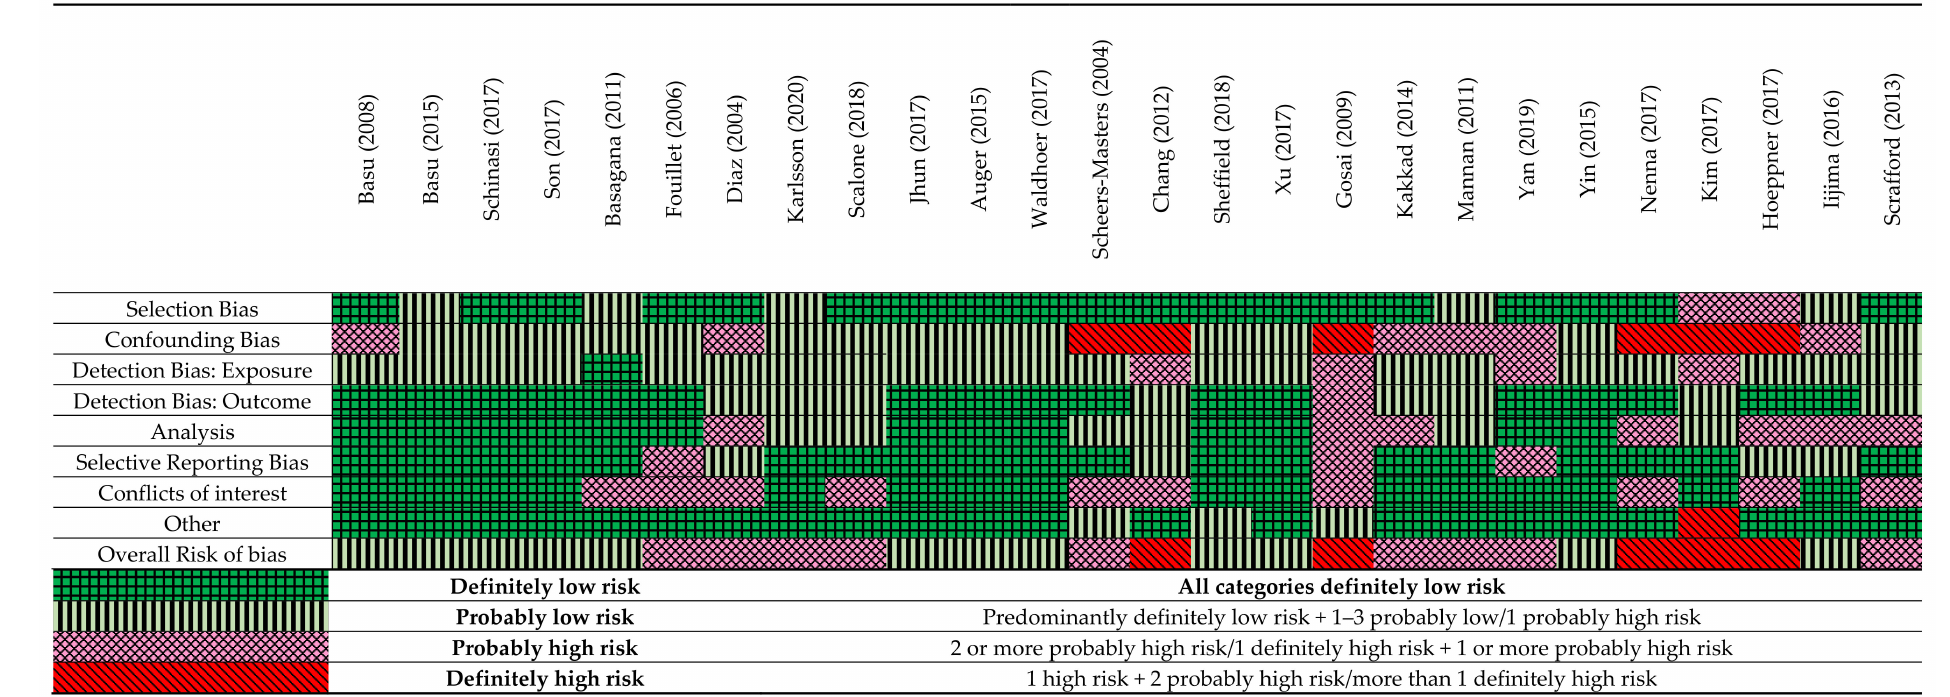
Figure 3. A summary of the critical appraisal using a modified OHAT Risk of bias tool